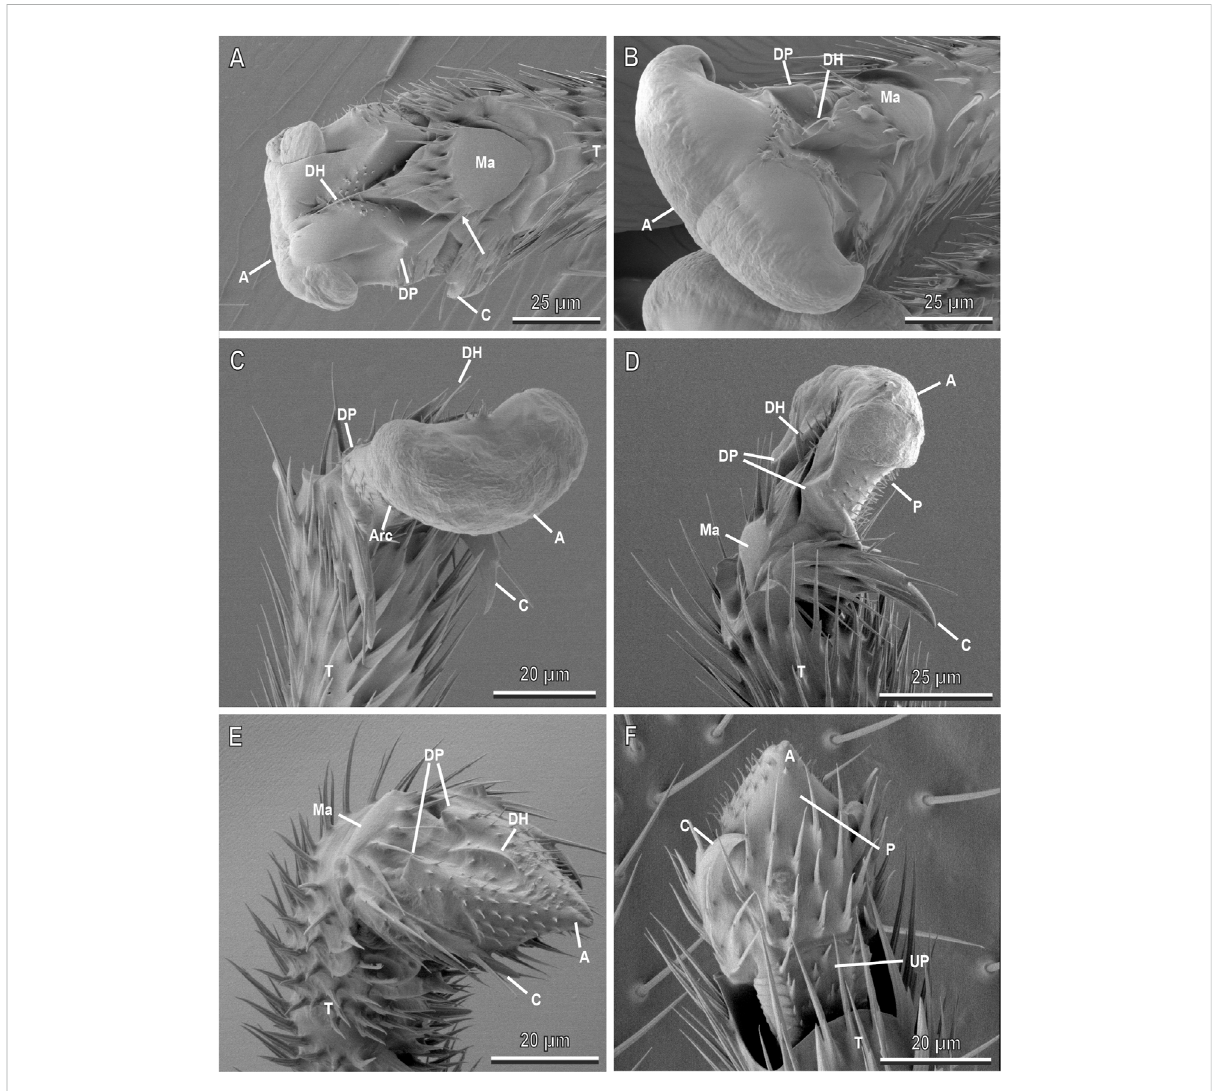
FIGURE 5 Pretarsal attachment devices of A. bifasciatus in cryo-SEM. (A) , Dorsal view of the female pretarsus showing the partially everted arolium (A) articulated to the fi fth tarsomere (T) through the manubrium (Ma) with 5 – 6 long hairs (arrow) and one distal hair (DH). The arolium is supported by dorsal sclerites named dorsal plates (DP) in continuity with the arcus surrounding the arolium proximally and ventrally; (B) , Dorsal view of the female pretarsus with the everted arolium formed by two big lobes separated by a dorsal deep median cleft; (C) , Latero-frontal view of the male pretarsus with theeverted arolium. The dorsal plates are in continuity with thearcus (Arc)surrounding thearolium proximally and ventrally. Notethe wrinkled surface; (D) , Lateral view of the male pretarsus with the everted arolium; (E) , Latero-frontal view of the male pretarsus with the inverted arolium; (F) ,Ventralviewofthemalepretarsuswiththeinvertedaroliumincontinuitywiththeplanta(P)connectedtothequadrangularunguitractor plate (UP) with microtrichia and scales. C,